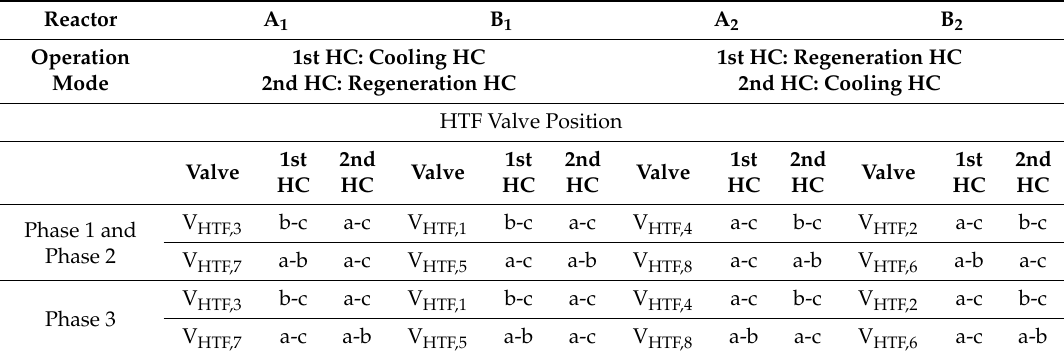
Table 2. States of operation and HTF/H 2 valve positions.